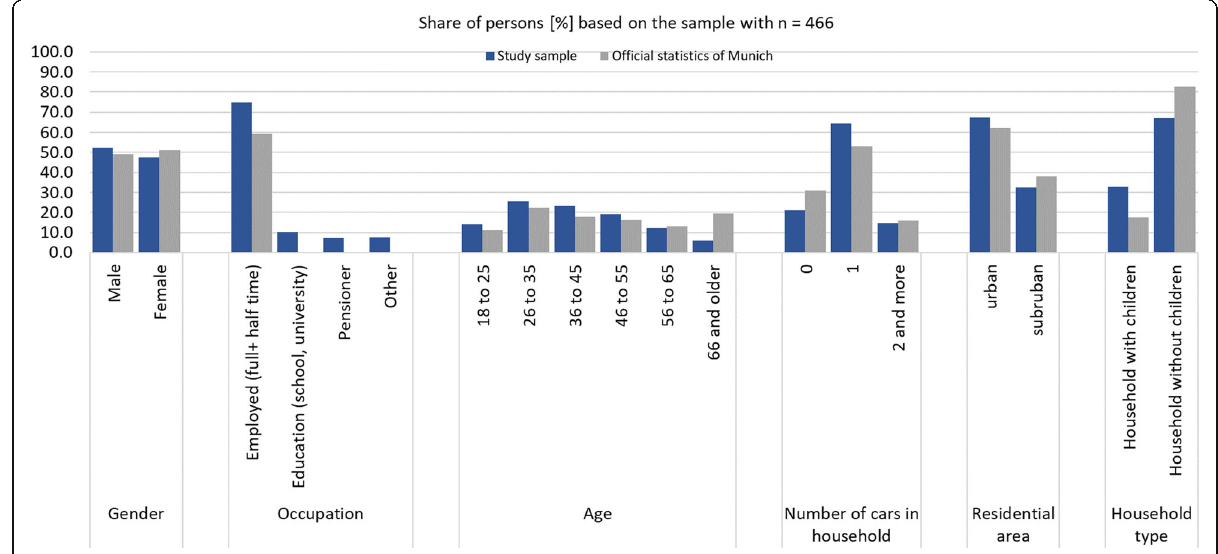
Fig. 1 Characteristics of the study sample compared to official statistics of